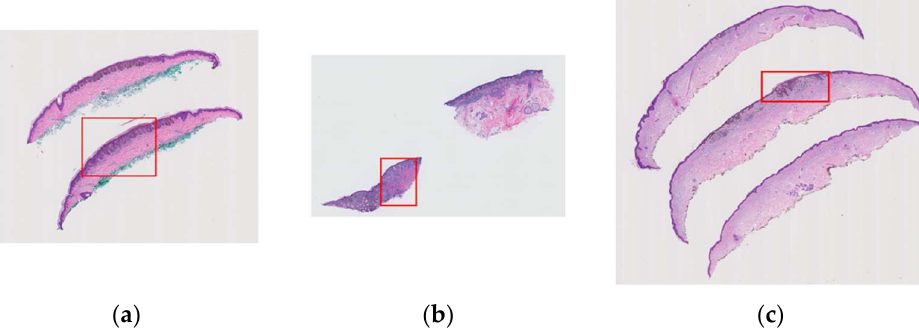
Figure 2. Examples of variable-sized region of interests (ROI) assigned by pathologists that contain important diagnostic information are shown in red boxes: ( a ) a case with class II diagnosis (moderately dysplastic nevus), ( b ) a case with class V diagnosis (invasive melanoma stage ≥ T1b), ( c ) a case with class IV diagnosis (invasive melanoma stage T1a).